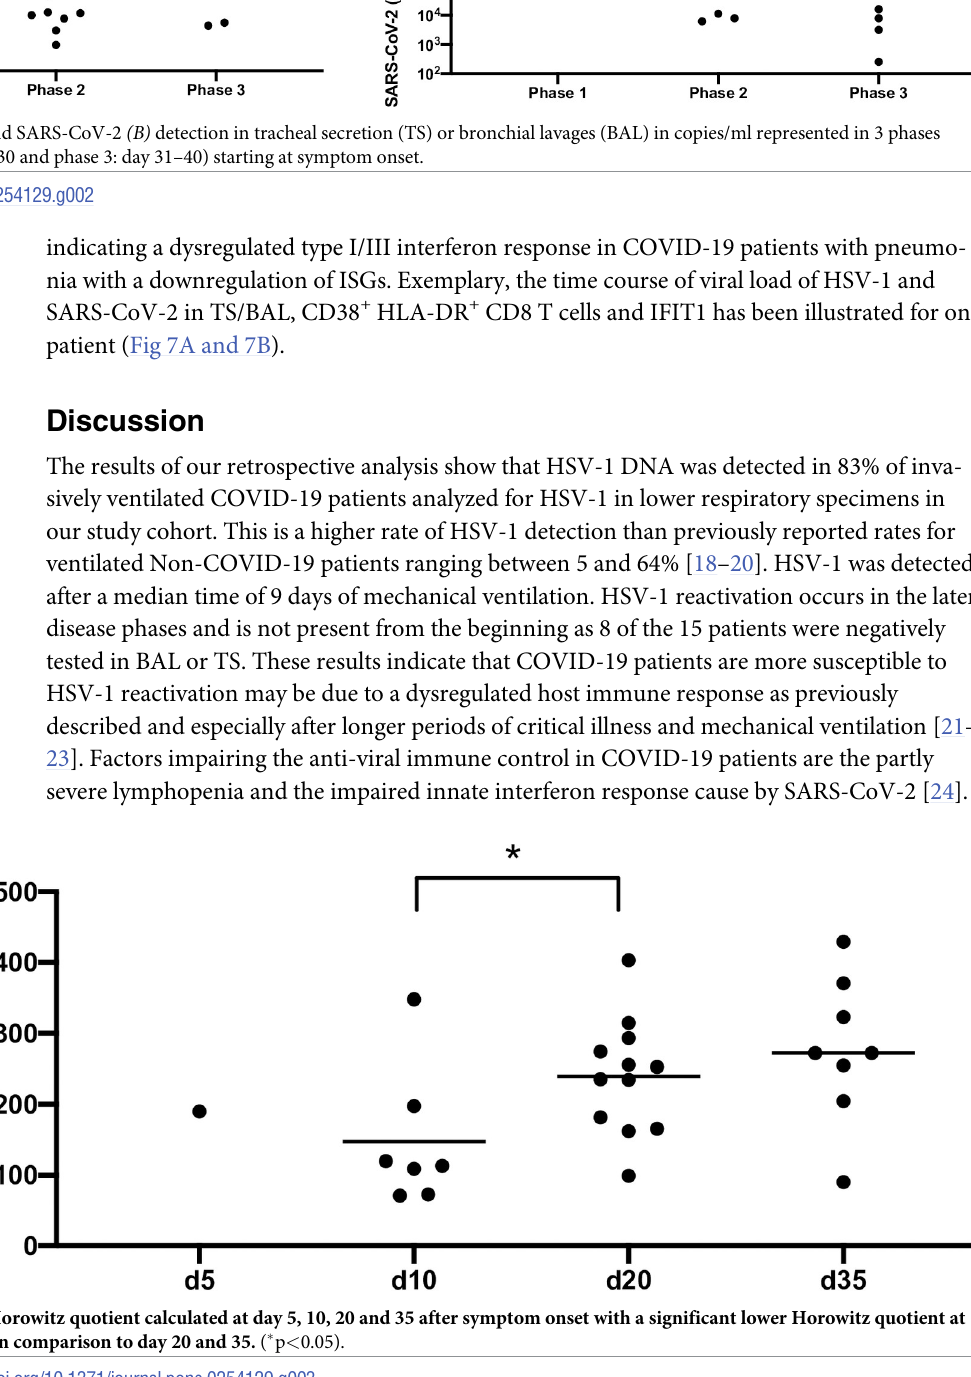
PLOS ONE | https://doi.org/10.1371/journal.pone.0254129 July 1,